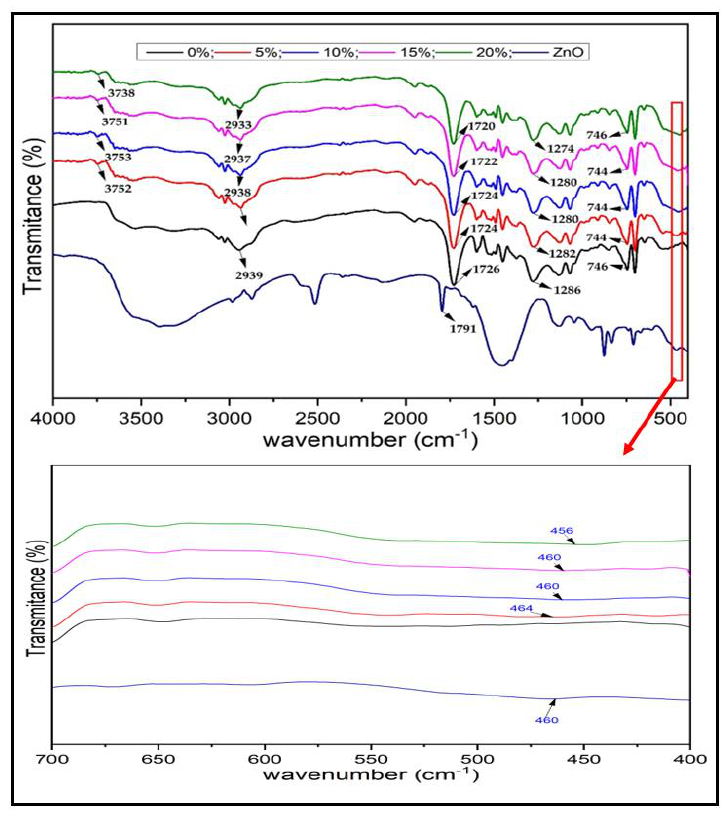
Figure 7. FTIR spectra of foamed polymer composites at different ZnO fillers.